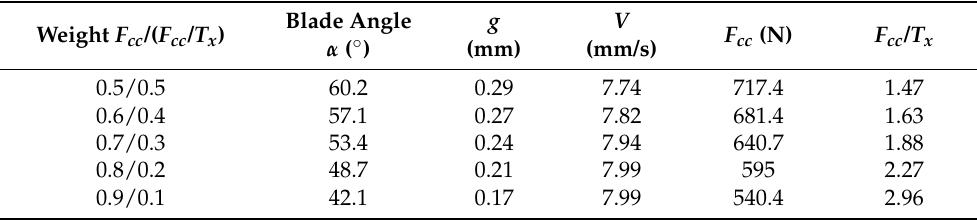
Table 9. Process parameters meeting the criteria for digital